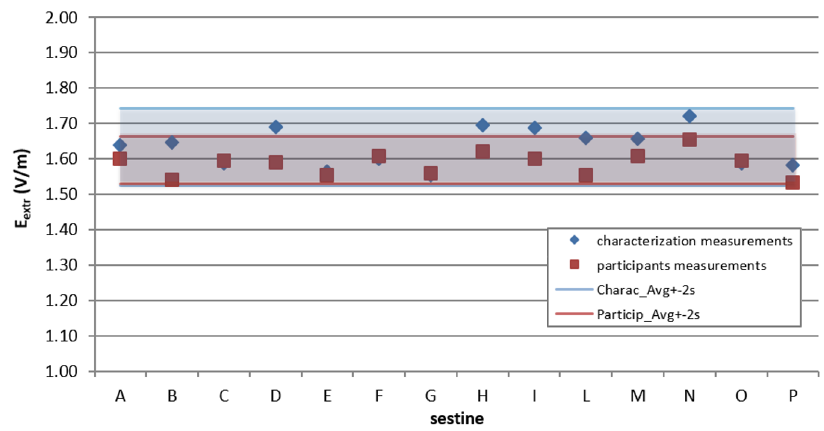
Figure 5. Graphical representation of the results of characterization measurements (sestet) of E LTE_RS and participants’ measurements with their variability ranges.